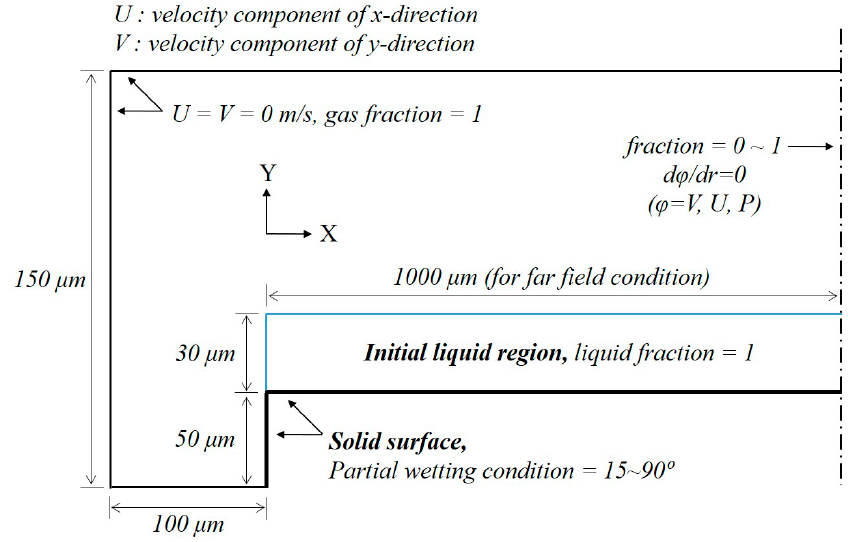
Figure 1. Schematic of the computational domain and boundary conditions of the coating fluid.